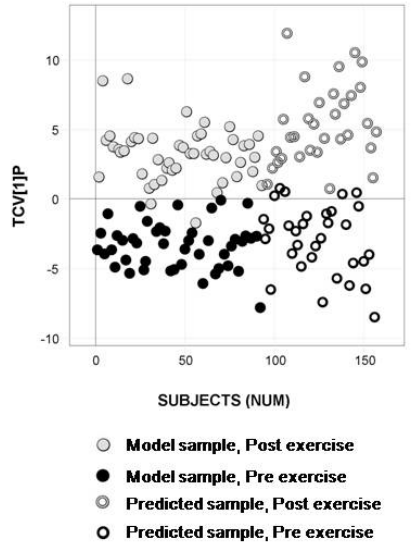
Figure 6. Longitudinal sample predictions in the classification model for the entire sample set. OPLS-DA predictive score plot for the model based on the 93 samples from exercise occasions one and two showing separation between pre- exercise (black circles) and post- exercise (gray circles) serum samples (Class prediction (CV): 97.8%). Predicted test samples from exercise occasions three and four marked as open circles display high predictive classification accuracy (Class prediction (Test set): 92.2%) for pre- exercise samples (black open circles) and post- exercise samples (gray open